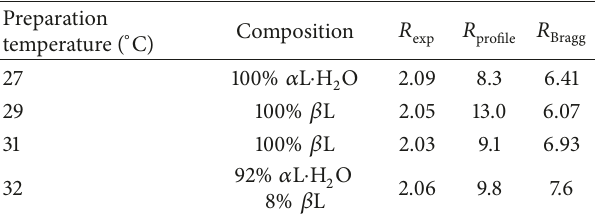
Table 2: Relative percentage of each phase determined by the Rietveld